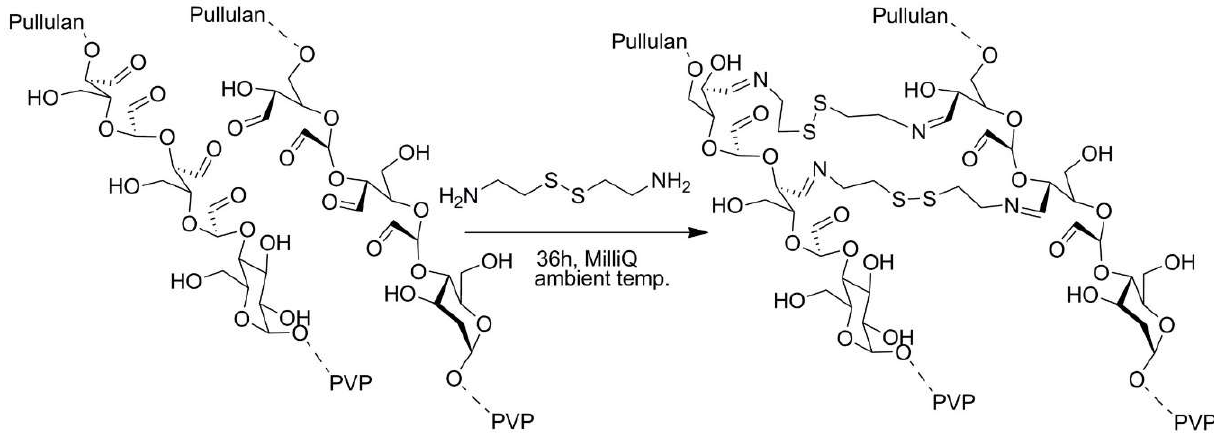
Scheme 15. Stabilization of microparticles from Pull- b -PVP copolymer with oxidized hydroxyl groups by crosslinking using using cystamine dihydrochloride. cystamine